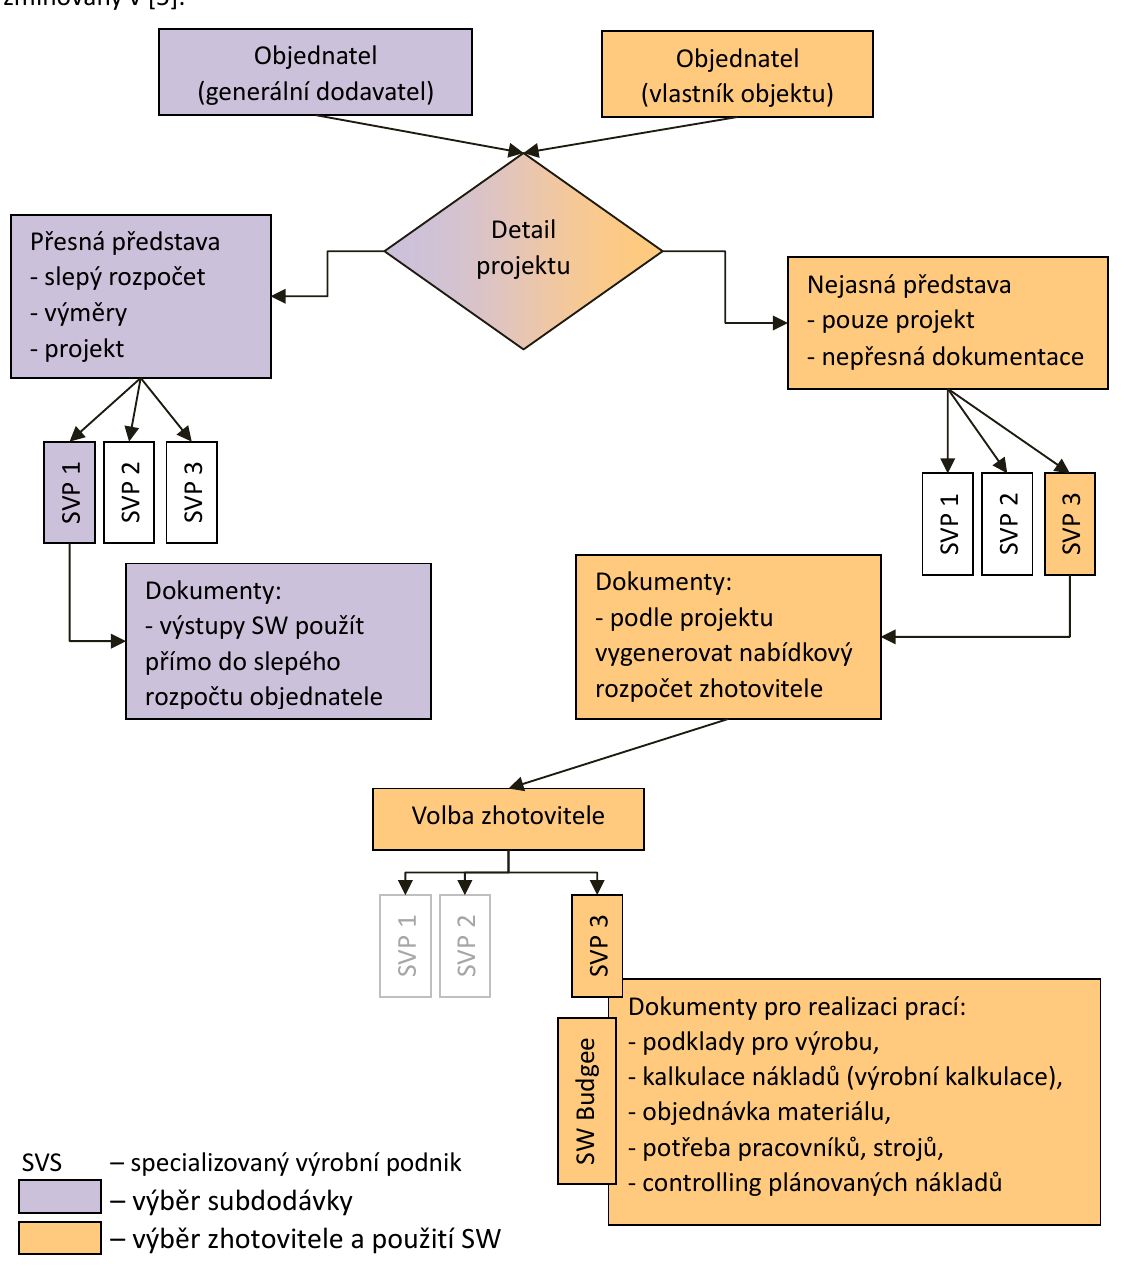
Figure 2: Použití generovaných dokumentů při výběru zhotovitele zakázky (zdroj: autor) Na obrázku 2 je schematicky znázorněno použití automaticky sestavených dokumentů, které tvoří aplikační nadstavba na základě definovaných položek. Na rozdíl od rámcových ukazatelů použitých v [6] se jedná o výrazně přesnější postup. Při získávání zakázky se uplatňuje nabídkový rozpočet pro objednatele, na základě kterého dojde k výběru finálního zhotovitele. V průběhu zakázky se